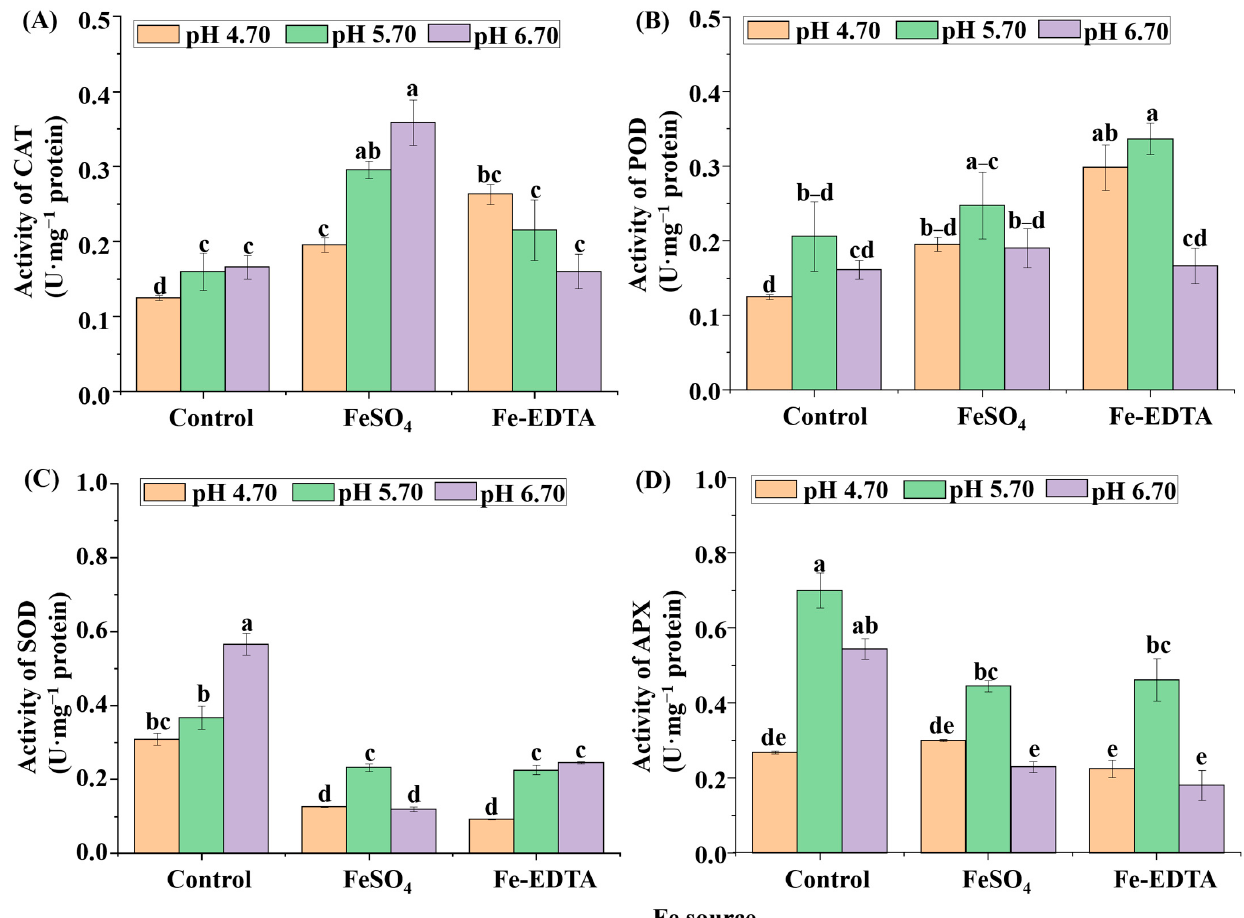
Figure 8. The activities of catalase (CAT) ( A ), guaiacol peroxidase (POD) ( B ), superoxide dismutase (SOD) ( C ), and ascorbate peroxidase (APX) ( D ) in H. macrophylla after 60 days of culture. Lowercase letters indicate significant differences calculated by Duncan’s multiple range test at p ≤ 0.05. Vertical bars indicate the standard error ( n = 3).